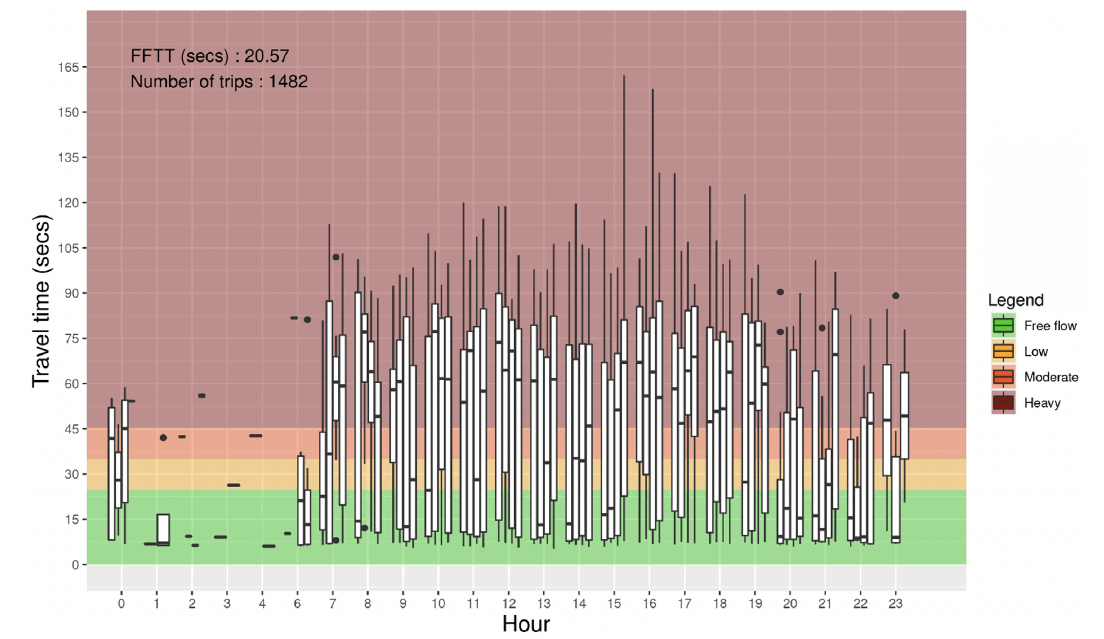
Figure 8. Travel time boxplots as a function of time of the day with TTI classes observed on osm_id 427640838 (fraction start-end: 0.31–0.42) (Chemin Sainte-Foy west, Quebec